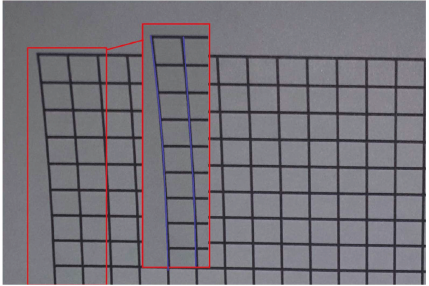
Figure 8: Computing Level and Level from a grid-based image: 0 1 Level is presented as the corners of the green grid. Level 0 marked as blue dots in the center of each green square.